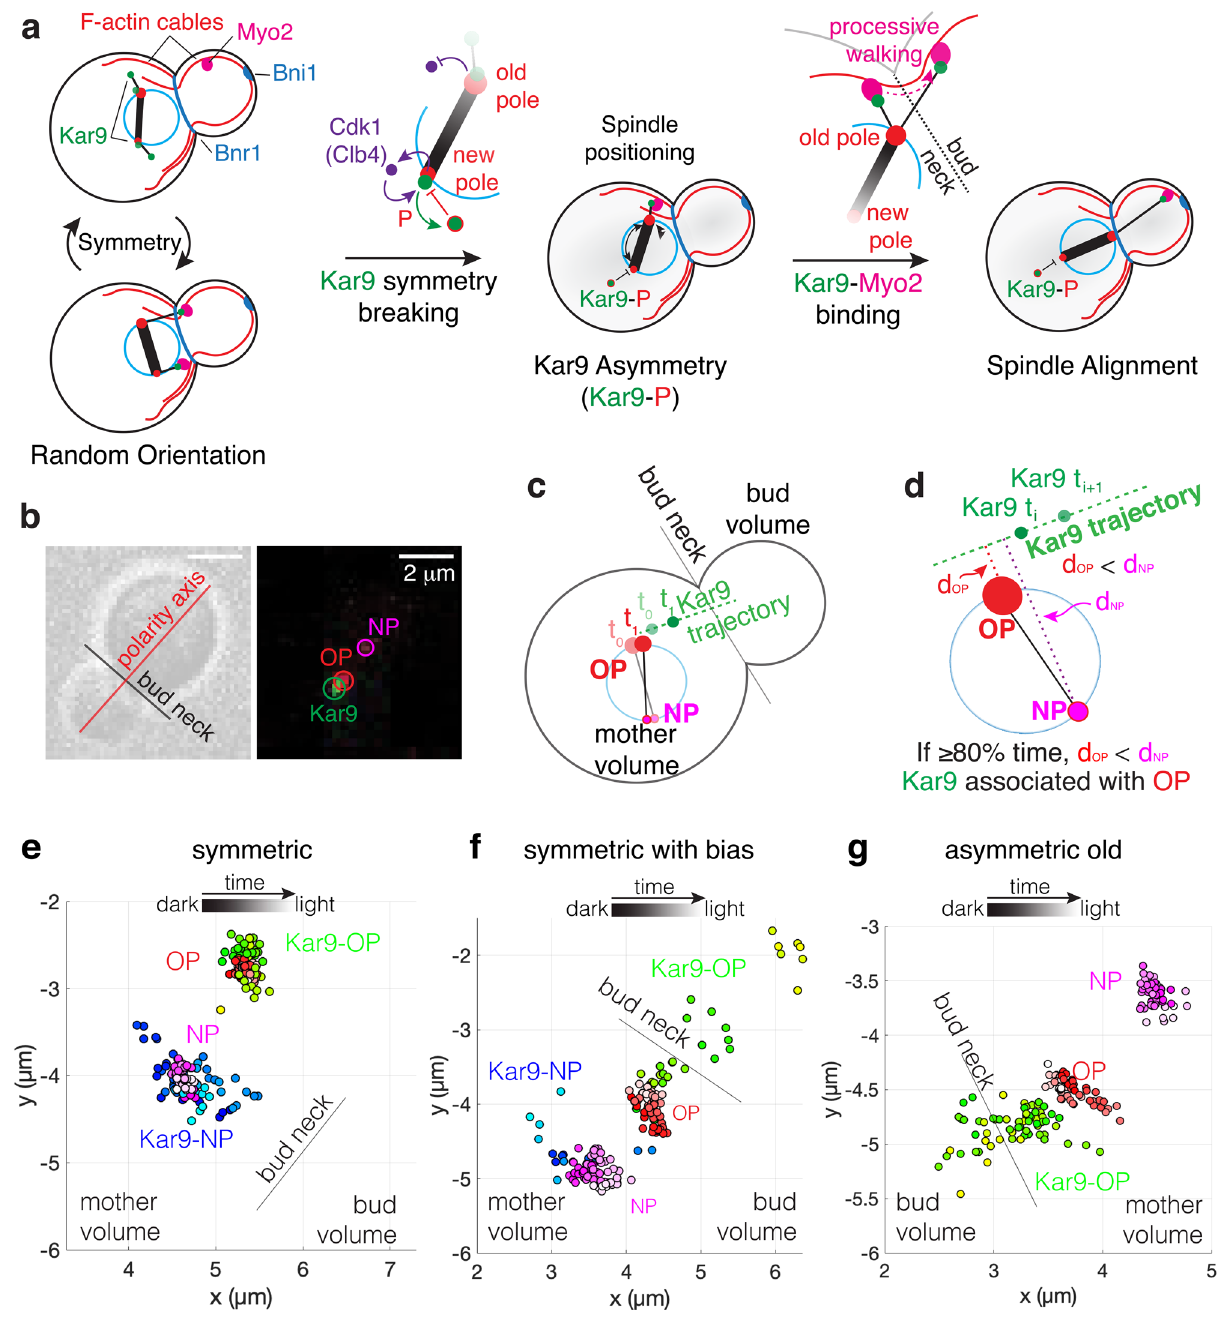
Figure 1. A trajectory-based method of Kar9-pole association. ( a ) After bipolar spindle formation, the spindle is randomly oriented. Both spindle poles and associated aMTs are decorated with Kar9. In this regime, Kar9 from both poles may interact with Myo2, thus causing both poles to be directed toward the bud, resulting in misalignment. Symmetry is broken by Cdk1/Clb4, where Kar9 at the new pole is targeted and phosphorylated by this complex. Once Kar9 asymmetry is achieved, the spindle is amenable to spindle positioning. This occurs through the processive walking of the Kar9-Myo2 complex toward the bud tip, resulting in spindle alignment. ( b ) Representative brightfield image used to determine bud neck and polarity axis and representative fluorescent image (max-projected). Old and new pole are differentiated based on fluorescence intensity. Scale bar 2 μm. ( c , d ) Graphical description of trajectory method. ( e ) An example of a symmetric state: Kar9 associates with both old and new pole over the entire acquisition. ( f ) An example of a symmetric state with bias: these cells fluctuate between symmetry and asymmetry. ( g ) An example of an asymmetric old cell: Kar9 associates exclusively with a single pole (old pole) over the entire